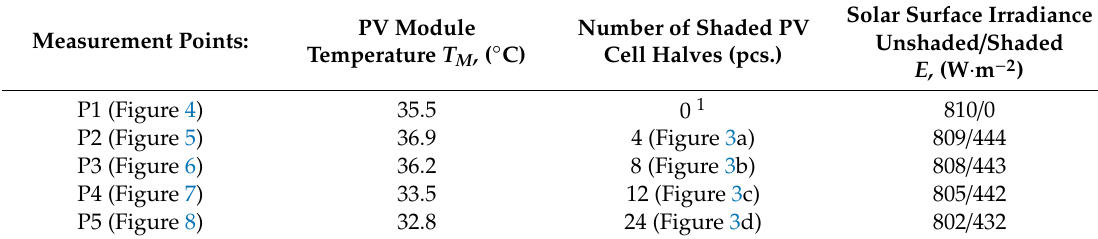
Table 2. List of parameters and conditions of verification measurements with links to relevant drawing numbers with the results of verification tests.